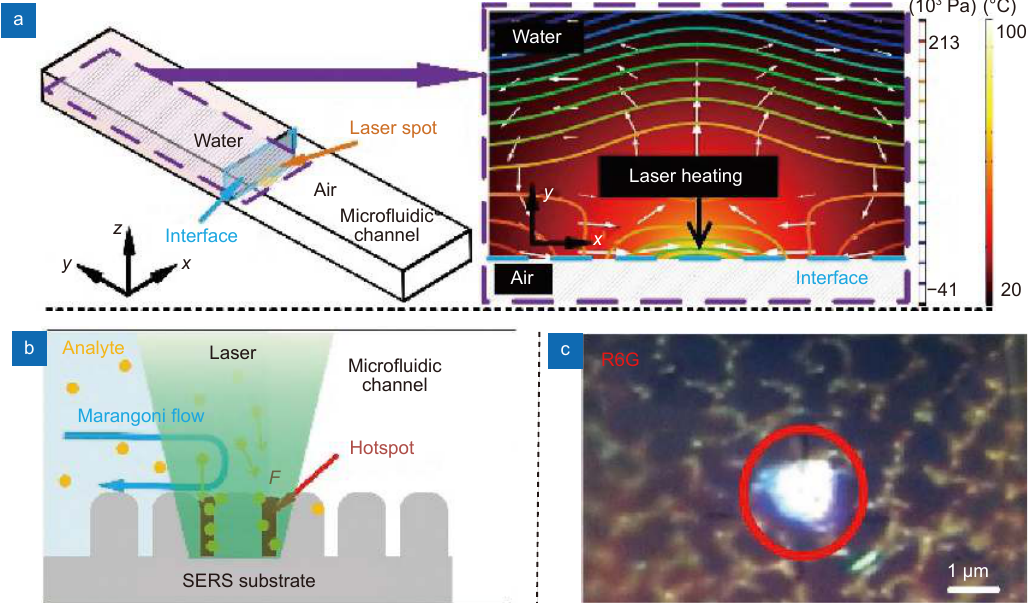
Fig. 4 | ( a ) Simulation of the fluid temperature and the pressure distributions in the liquid on the SERS substrate near the liquid-interface induced by laser heating. ( b ) The diagram of local aggregation of analyte molecules governed by Marangoni flow and optical trapping. ( c ) Immobilized R6G molecules on substrate by LI-SERS